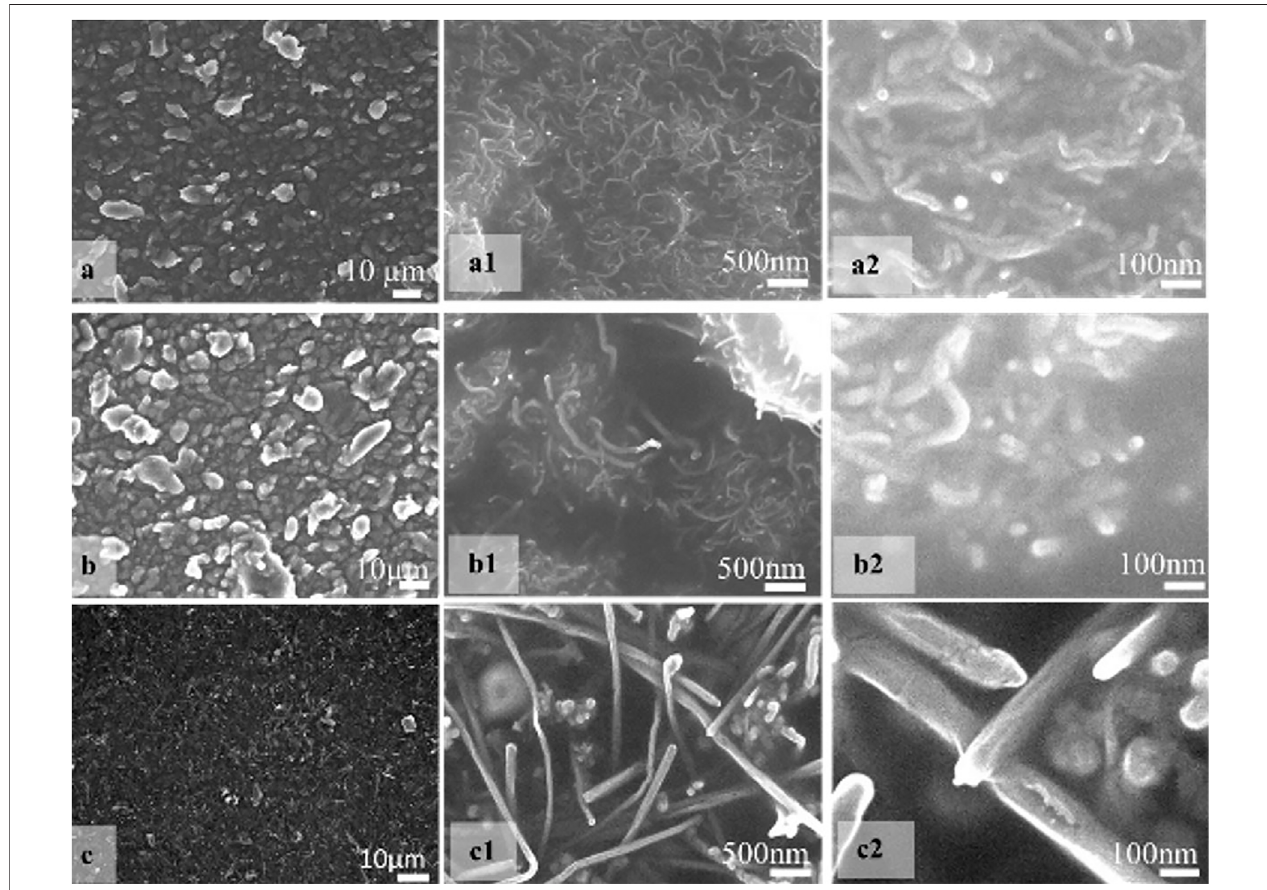
FIGURE 9 | FE-SEM images show the surface morphology of (A − A2) PDMS-PEIE/MWCNTs-1, (B − B2) PDMS-PEIE/MWCNTs-2, and (C − C2) PDMS-PEIE/ MWCNTs-3 at different magni fi cations (micrometric to nanometric size).